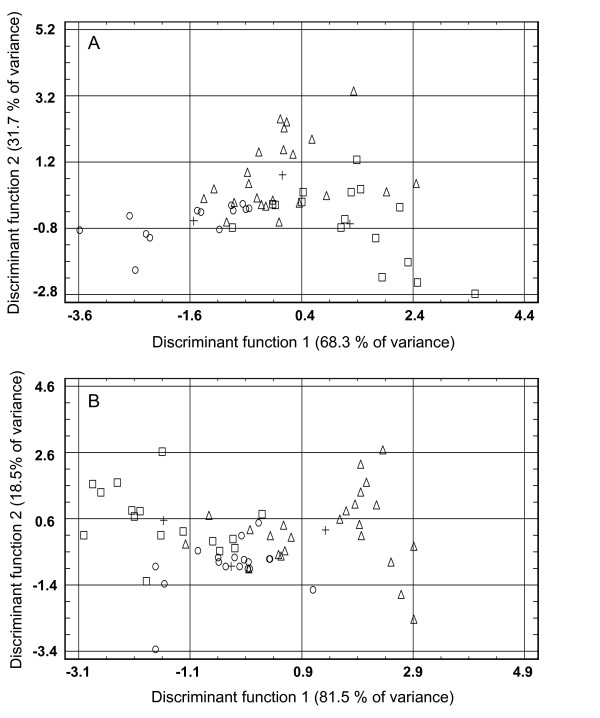
Scatter plots of Discriminant Analysis scores in mantle (A) and gill (B) tissues for un-challenged controls (circles) and clams challenged with washed (triangles) or unwashed (squares) QPX cells. Positions of group centroids for each treatment are indicated by a black cross.